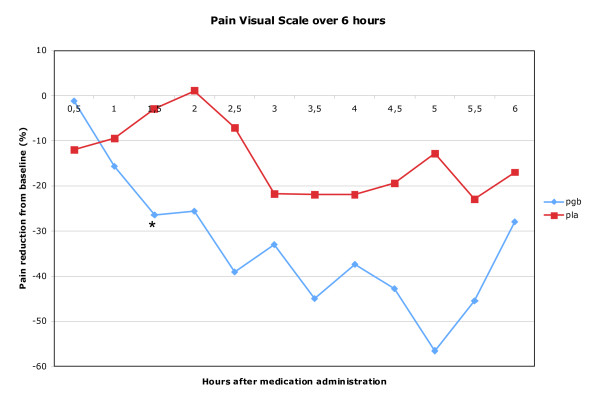
Percent reduction in median pain VAS (placebo and pregabalin) at specific time points after medication administration. A larger negative number means greater reduction in pain. * p < 0.05.